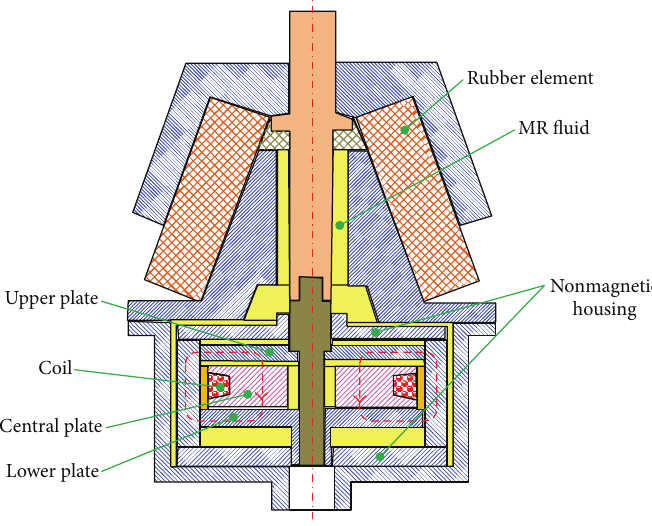
Figure 12: Configuration of high loaded MR